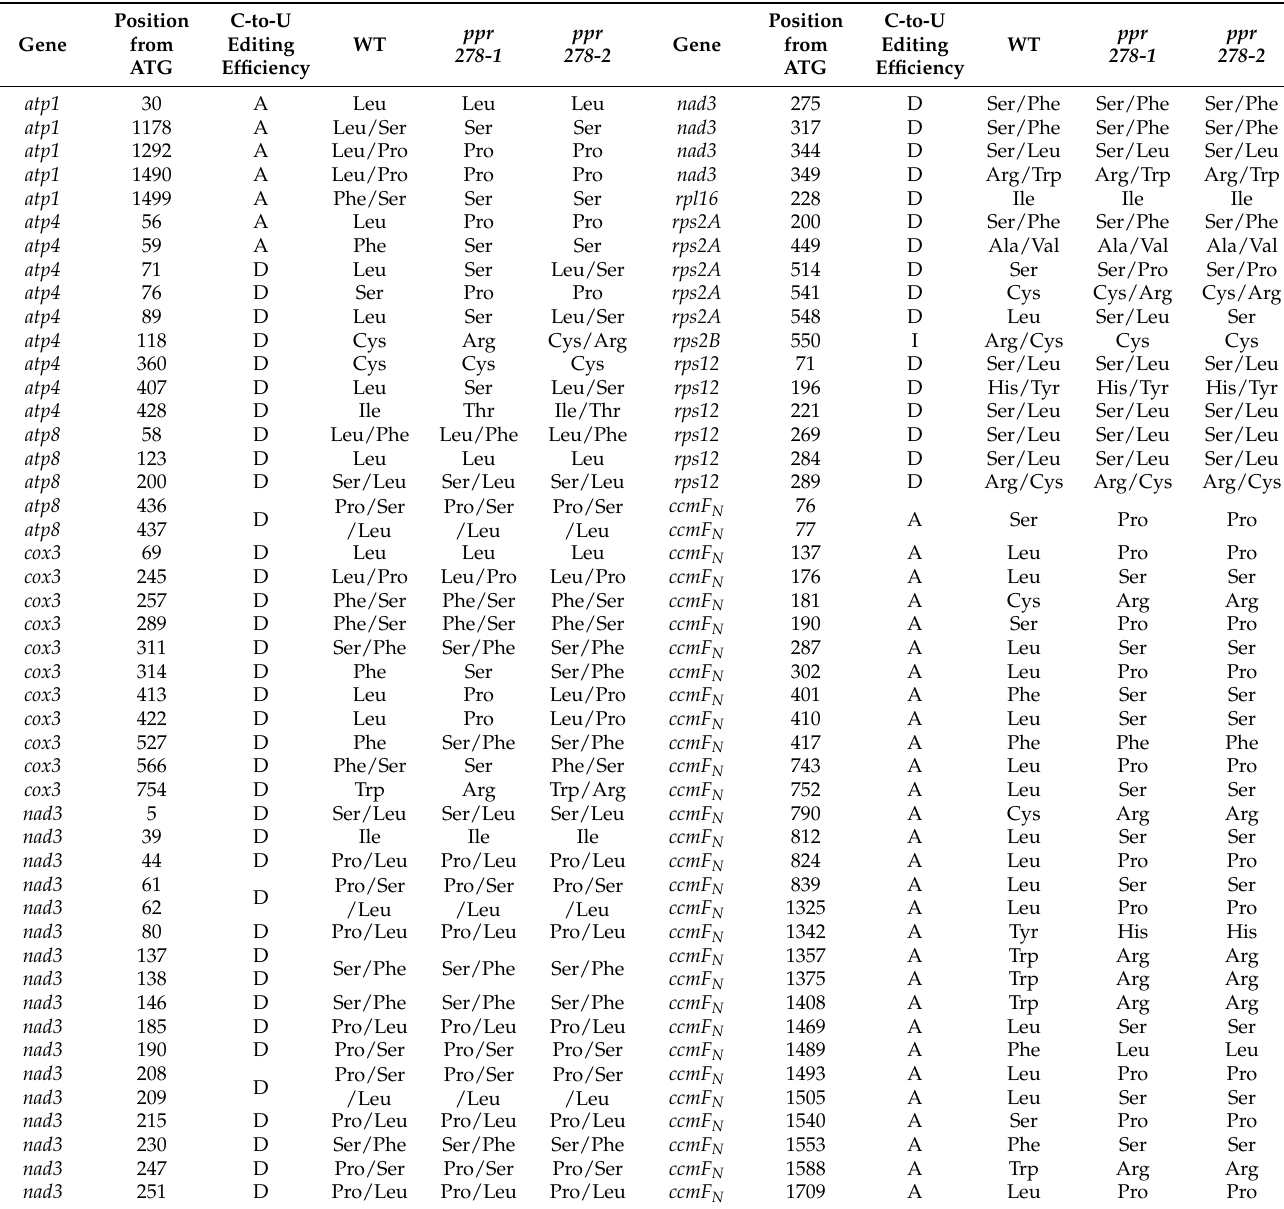
Table 1. Comparison of editing profiles that differ between WT and ppr278